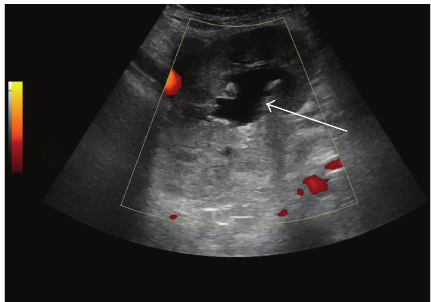
Figure 3: Doppler ultrasound performed on post-op day 1 after surgical detorsion demonstrated normal arterial blood flow with residual mild hydronephrosis and persistent enlargement of the renal